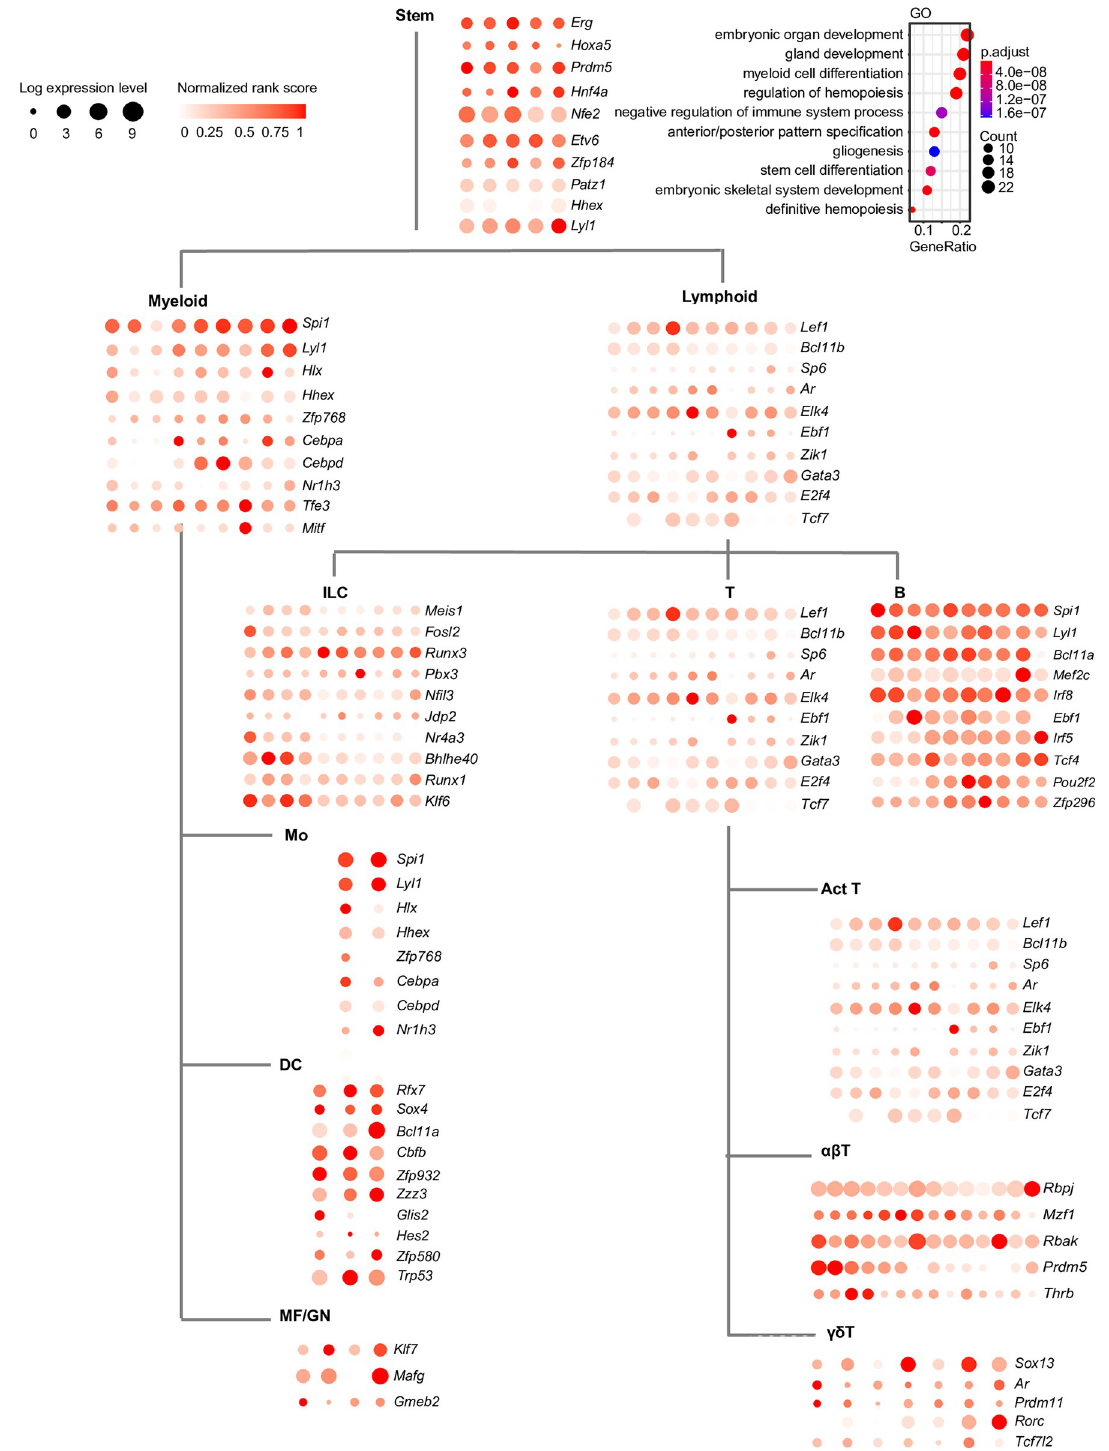
Fig 4. Cell lineage-specific putative driver TFs in the mouse immune system. A P-value of 0.005 and log2 fold change of 0.5 were used to call the putative driver TFs in each cell lineage. The bubble plots show the top 10 putative driver TFs and for “Lymphoid” and “T” lineage, only “Act_T” samples are shown as example due to limited space. The GO term enrichment analysis for stem cells is shown as an example.